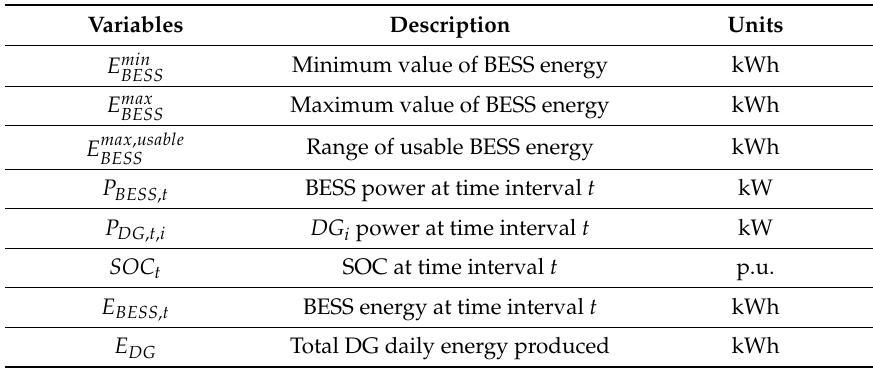
Table 4. List of variables in the LP